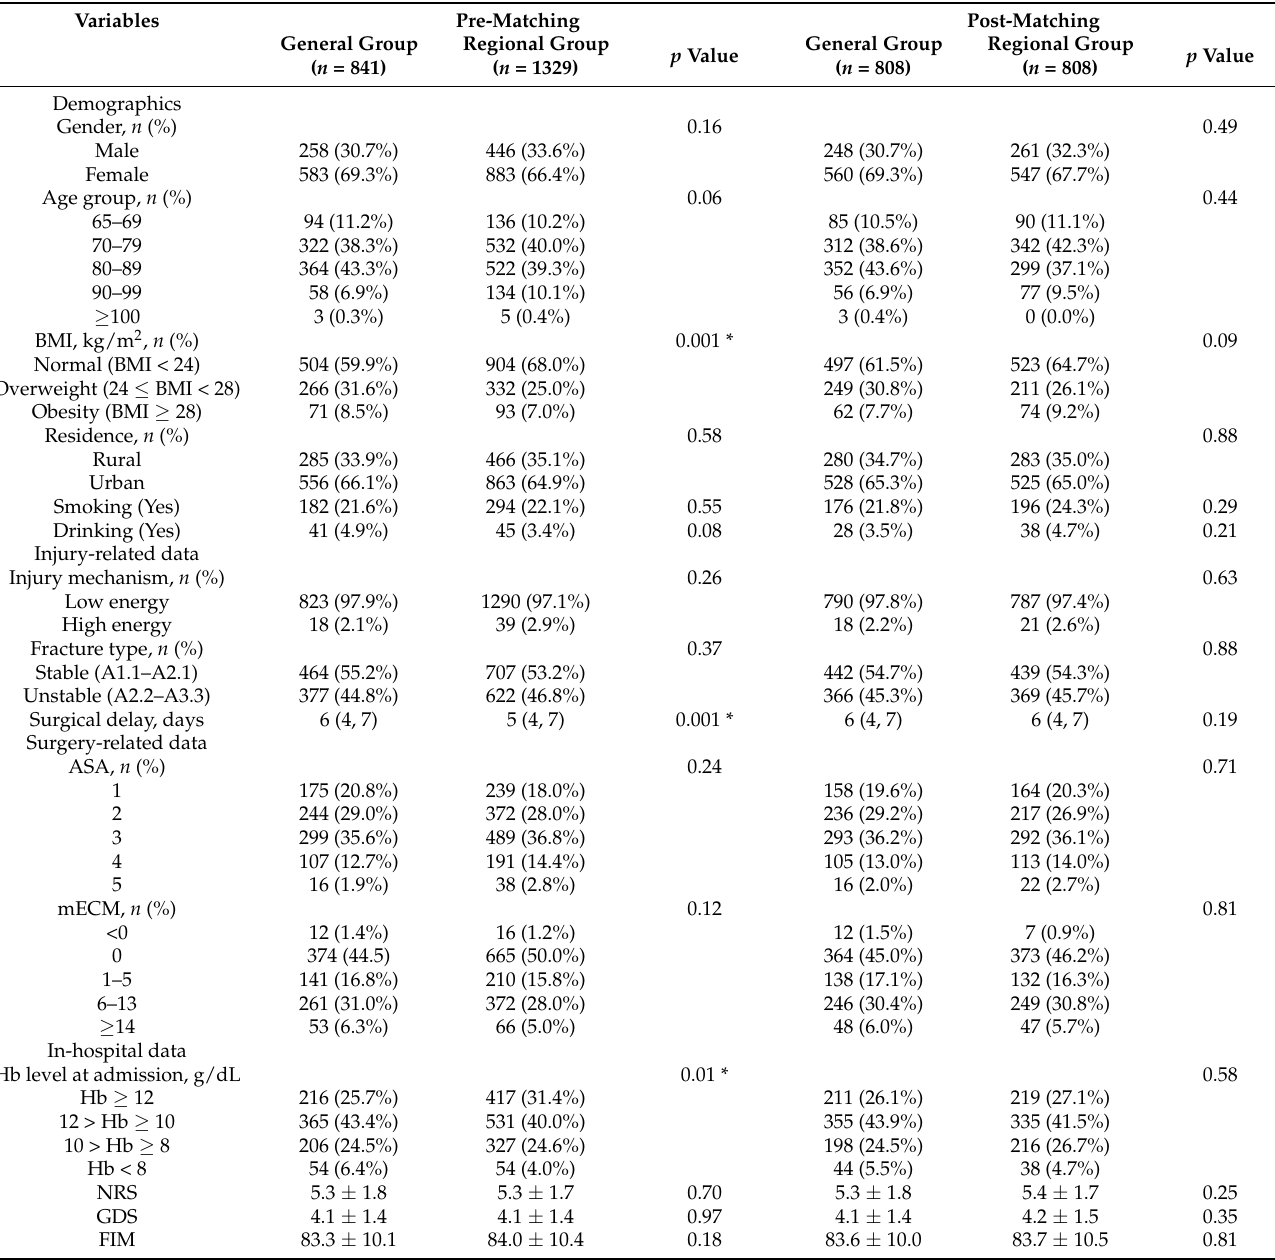
Table 1. Comparisons of patient characteristics at baseline before and after propensity score